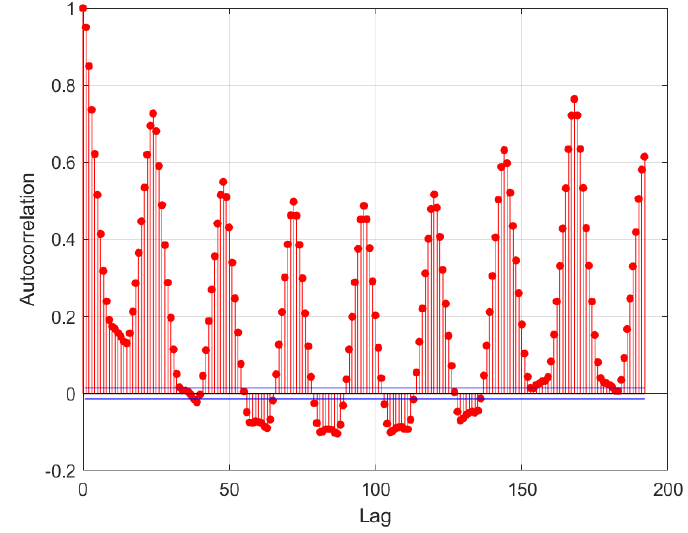
Figure 12. Total autocorrelation for the energy demand.